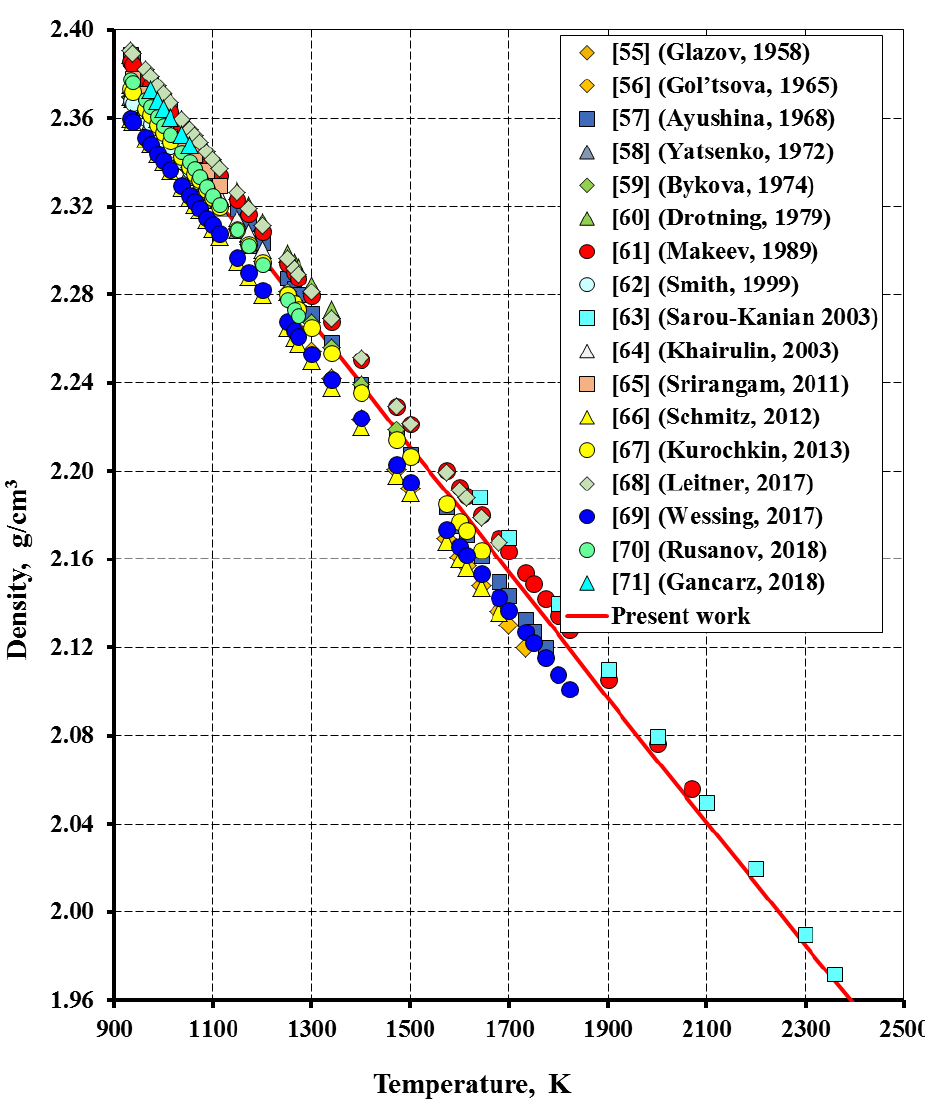
Figure 6. Density of liquid aluminum plotted versus temperature.